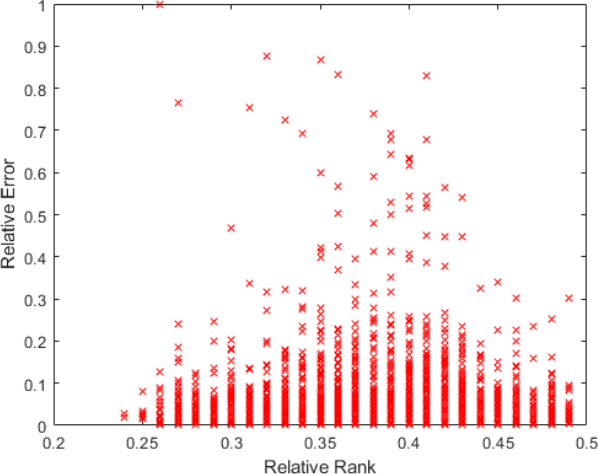
Figure 15. Pattern distribution according to their Relative Error and Relative Rank in X 4 .